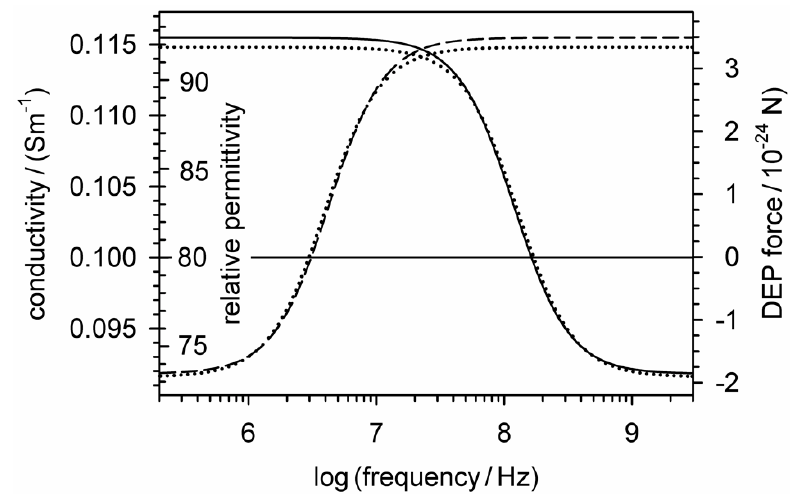
Figure 4. Relationships of the real parts of the relative permittivity and conductivity (Equations (26) and (36)) of the suspension containing two different homogeneous spheres (Dashed lines: σ i = 0.01 S/m, ε i = 800; solid lines: σ i = 1 S/m, ε i = 8) to the induced DEP force (Equation (27)). The DEP forces are identical to those in Figure 3 when using the relative permittivity and conductivity of the suspension medium (80, 0.1 S/m) as a reference for zero DEP force. The dotted lines show the classical DEP force (Equation (10)).